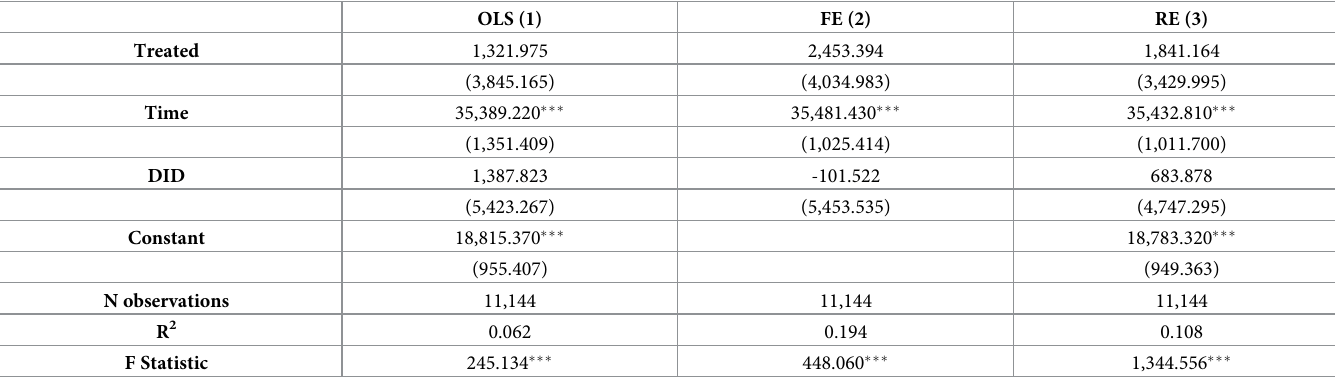
Table 7. Difference-in-differences agriculture GVA results: Pooling, fixed-effects, and random-effects .